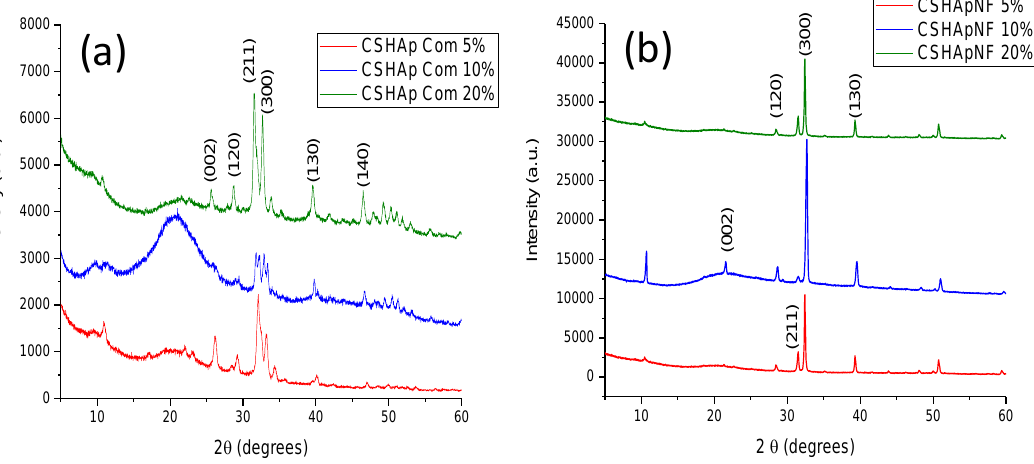
Figure 5. XRD diffractograms of ( a ) reference materials and ( b ) composite materials made of nanofibers. In both cases, the main Bragg reflections are indexed.